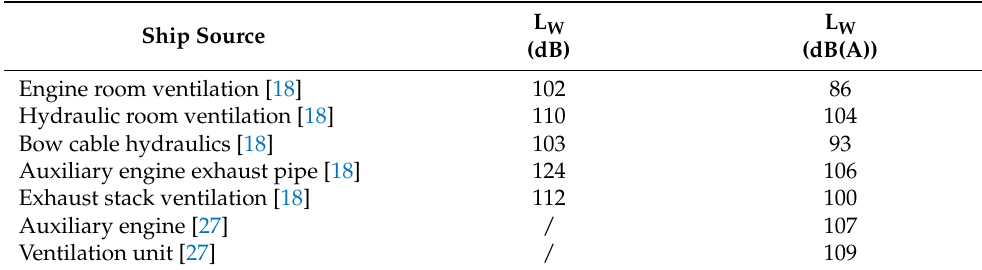
Figure 7. One-third octave sound power spectra of Ro-Ro vessel noise sources, as reported in [17]. L W is expressed in dB for point sources, in dB/m for linear sources and in dB/m 2 for area sources. Table 6. Comparison between data of EFFORT Project [18] and Tecnalia Report [27] related to the noise emission of some noise sources of Ro-Ro ships.